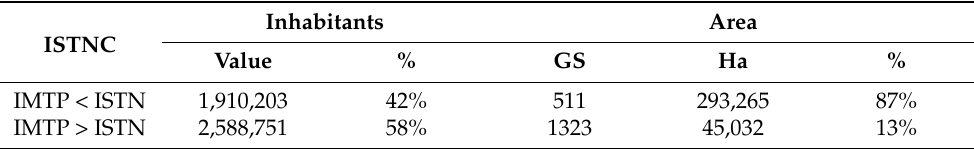
Table 4. Population and Surface related to Social Transport Needs Covered by SITEUR.